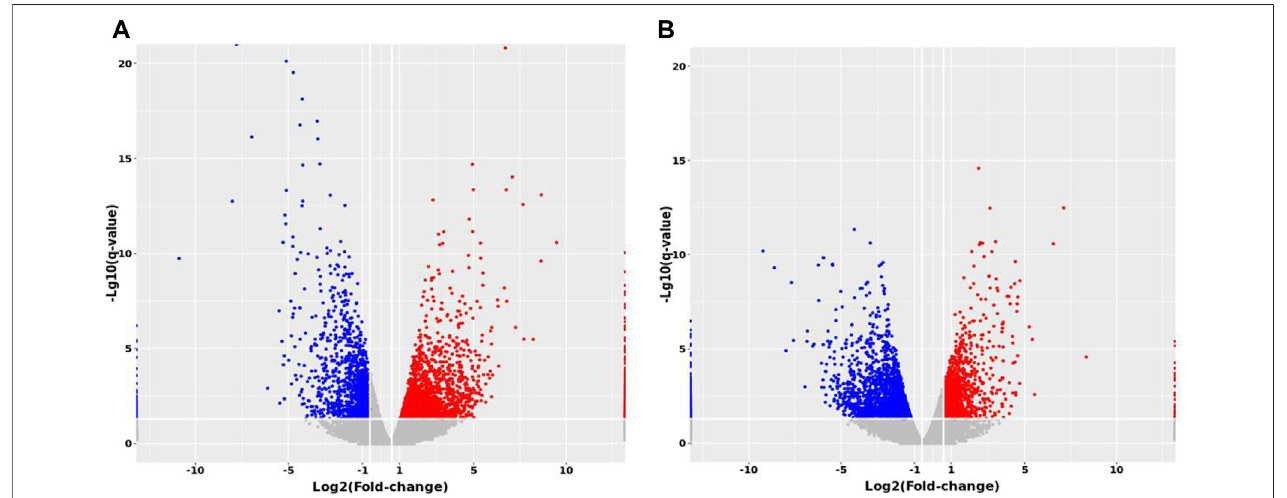
FIGURE 10 | Volcano maps of differentially expressed mRNAs between groups. (A) MTP vs. Control (B) MTP + CR vs. MTP.